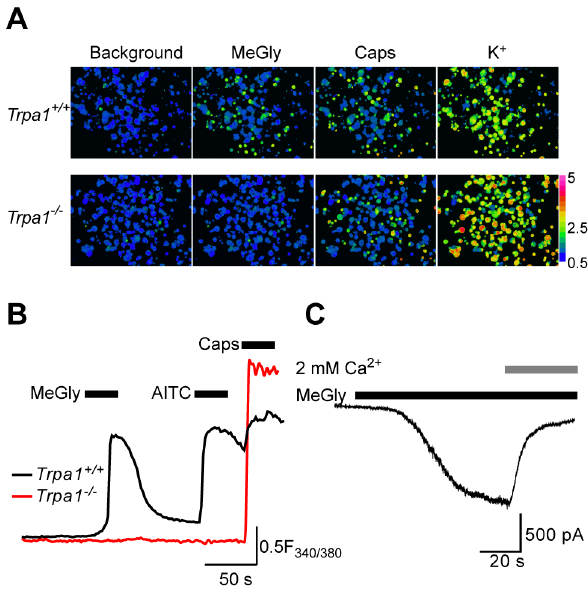
Figure 3. Methylglyoxal stimulates DRG neurons expressing TRPA1. (A) Pseudocoloured images illustrating [Ca 2 + ] i -concentrations in Fura-2 loaded cultured DRG neurons. MG evokes [Ca 2 + ] i -responses in TRPA1 containing neurons. (B) Typical examples of [Ca 2 + ] i -responses in capsaicin sensitive DRG neurons from Trpa1 + / + and Trpa1 2 / 2 mice. (C) MG activates characteristic TRPA1 currents in DRG neurons (holding potential -60 mV). Before addition of 2 mM Ca 2 + this neuron was superfused with a solution containing 15 m M Ca 2 + , which prevents the Ca 2 + -induced current surge.